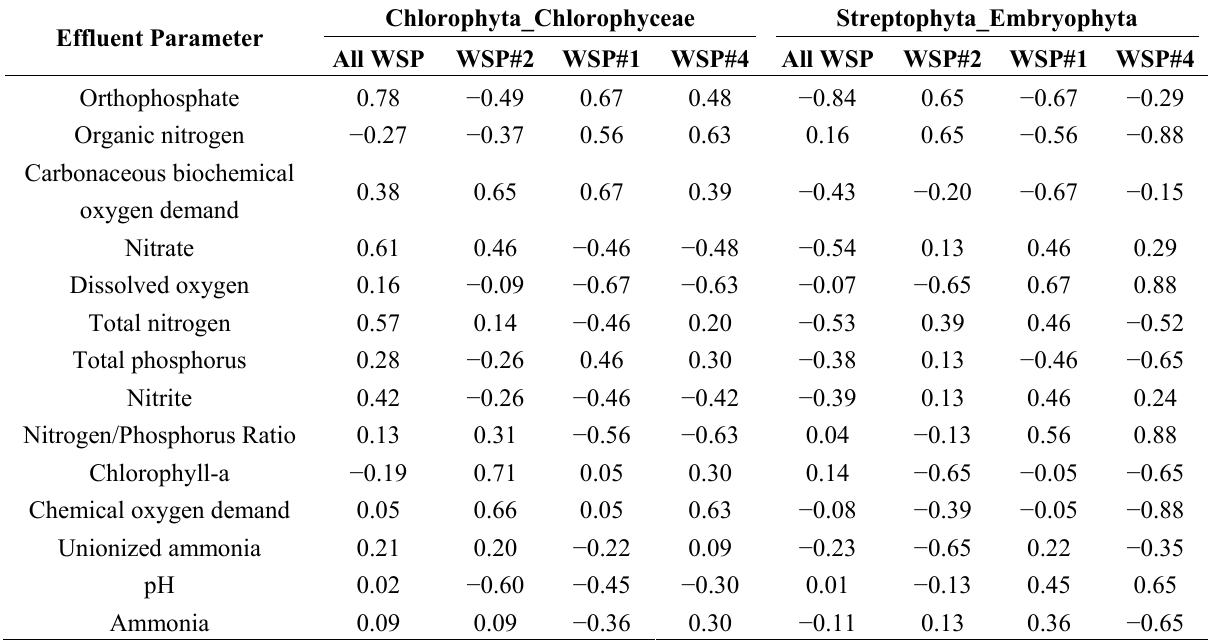
Table 5. Spearman rank correlation coefficients between embryophyta and chlorophyceae and water chemistry parameters measured at each of the WSP effluents and across all WSPs for the sampling dates, sorted by significance probability statistic (summed p -value; smallest to